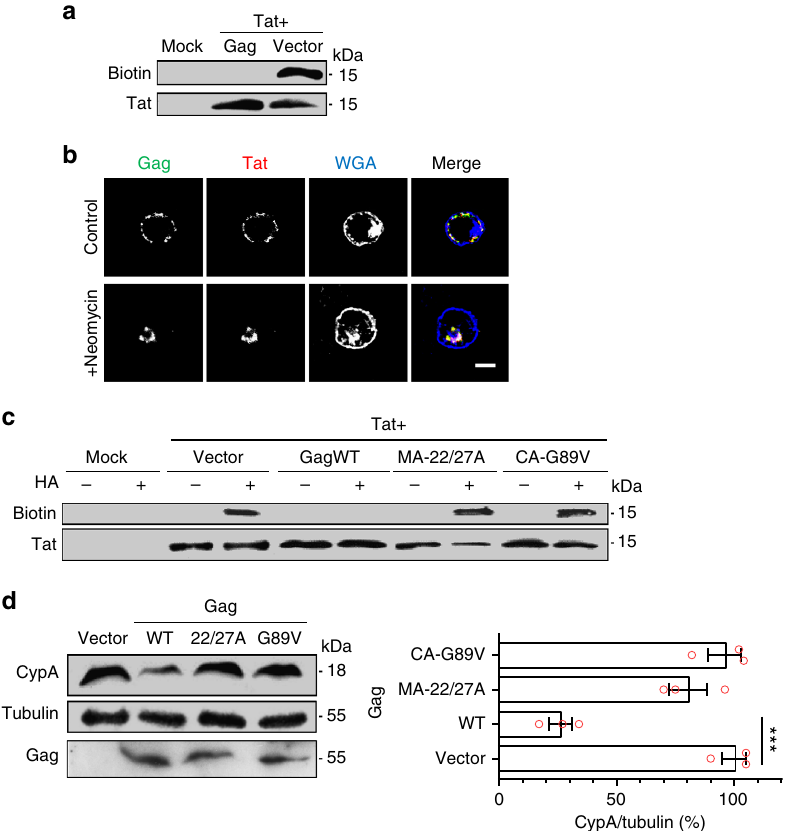
Fig. 8 HIV-1 Gag inhibits Tat palmitoylation by exporting Cyclophilin A. a PC12 cells were cotransfected with Tat-Flag and Gag (1/1 ratio) or an empty vector as indicated. Cells were then labeled overnight with 17-ODYA before assaying Tat palmitoylation using click chemistry. b Human primary CD4 + T- cells were infected with HIV-1 (NL4.3). After 24 h cells were processed for immuno fl uorescence detection of Tat and Gag, using fl uorescent WGA to localize the plasma membrane and the TGN. When indicated, cells were pretreated with 5 mM neomycin for 1 h before fi xation. Bar, 5 µ m. c PC12 cells were cotransfected (1/1) with Tat-FLAG and a Gag mutant or an empty vector as indicated before assaying Tat palmitoylation using ABE. Gag-MA-22/27A and Gag-CA-G89V are mutated within their PI(4,5)P 2 - and CypA-binding motif, respectively. d Jurkat T-cells were transfected with the indicated Gag mutant using nucleofection. Transfection ef fi ciency was ~80%. After 24 h, cells were lysed for Western blots. Triplicate blots were used for the quanti fi cation. Data are mean ± SEM ( n = 3) and were analyzed using one-way ANOVA (*** p <